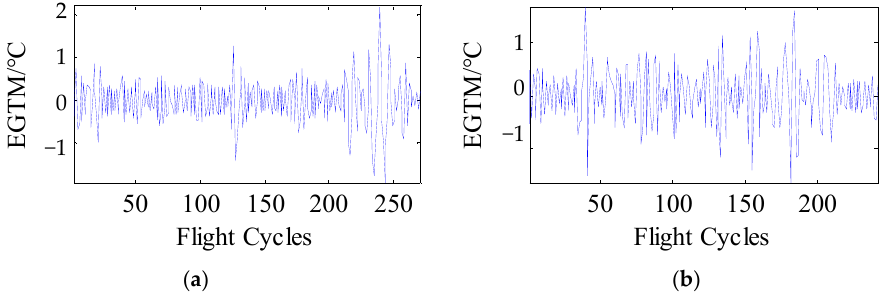
Figure 11. Components that contain the most noise in the testing data. ( a ) Data No. 7 contains the most noise data component; ( b ) Data No. 8 contains the most noise data component.